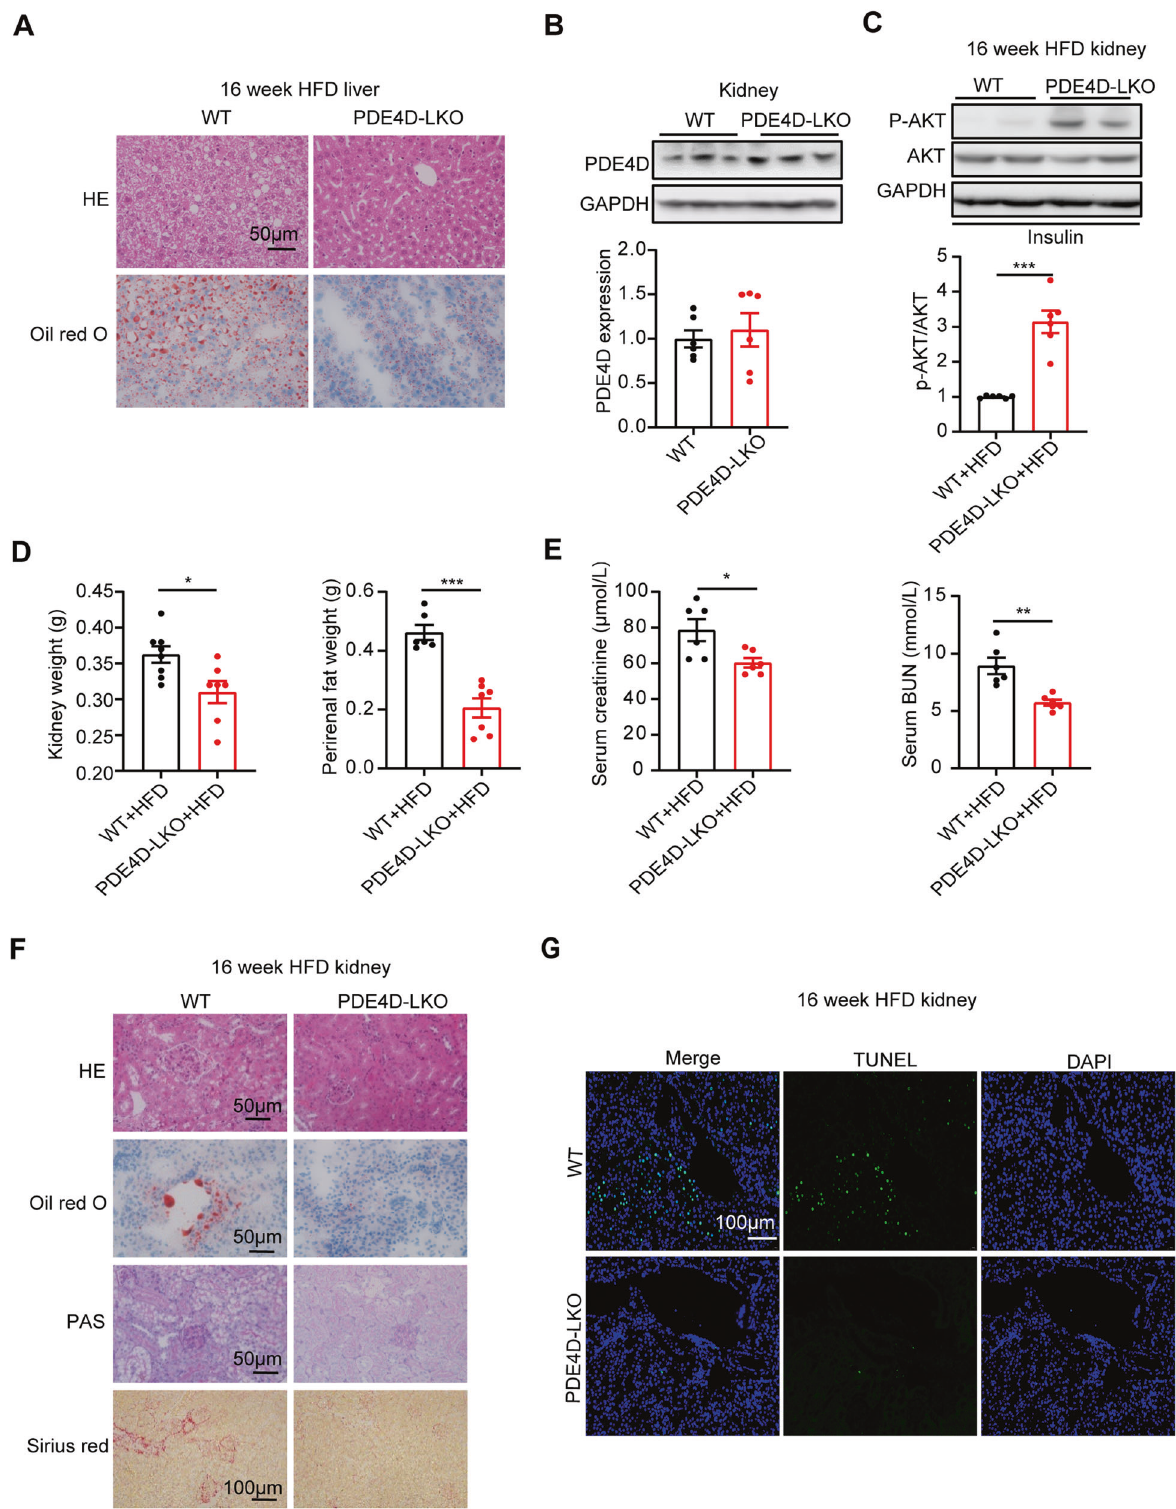
Fig. 3 PDE4D de fi ciency in the liver improved HFD-induced hepatic steatosis and associated renal damage. PDE4D-LKO and WT mice were fed a HFD for 16 weeks, and the liver and kidney were collected at week 16. A HE (upper panel) and Oil red O (lower panel) staining of mouse livers at week 16. B The protein levels of PDE4D in kidney tissue of WT and PDE4D-LKO mice. C Phosphorylation of AKT in kidney after mice were injected with insulin for 15 min ( n = 6). D Kidney and perirenal fat weight of WT and PDE4D-LKO HFD mice at week 16. E Serum creatinine and BUN levels of the two groups of mice ( n = 6). F HE, Oil red O, PAS, and Sirius red staining of mouse kidney. G TUNEL staining in kidney tissue of WT and PDE4D-LKO mice. Data are shown as the means ± SEMs. * P < 0.05, ** P < 0.01, *** P < 0.001 by two-tailed Student ’ s t test.